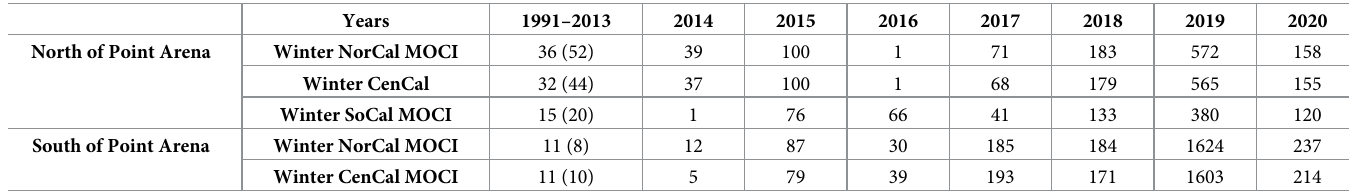
Error (precision) given in absolute percentages. The first data column indicates the predictability error for the model pre-collapse (1991–2013) including the average and standard deviation (in parentheses) values; the following columns show the predicted error for each year. NorCal: northern California, CenCal: central California, SoCal: southern